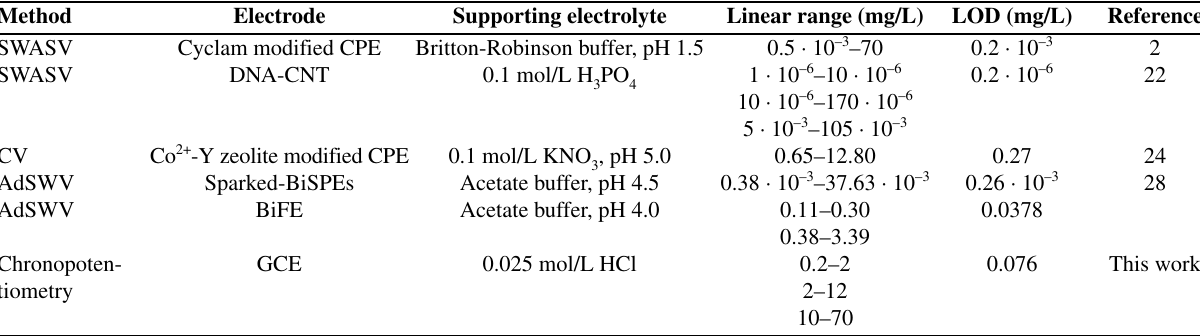
Table 5. Comparison of the proposed method with some previously reported electrochemical methods for determination of riboflavin